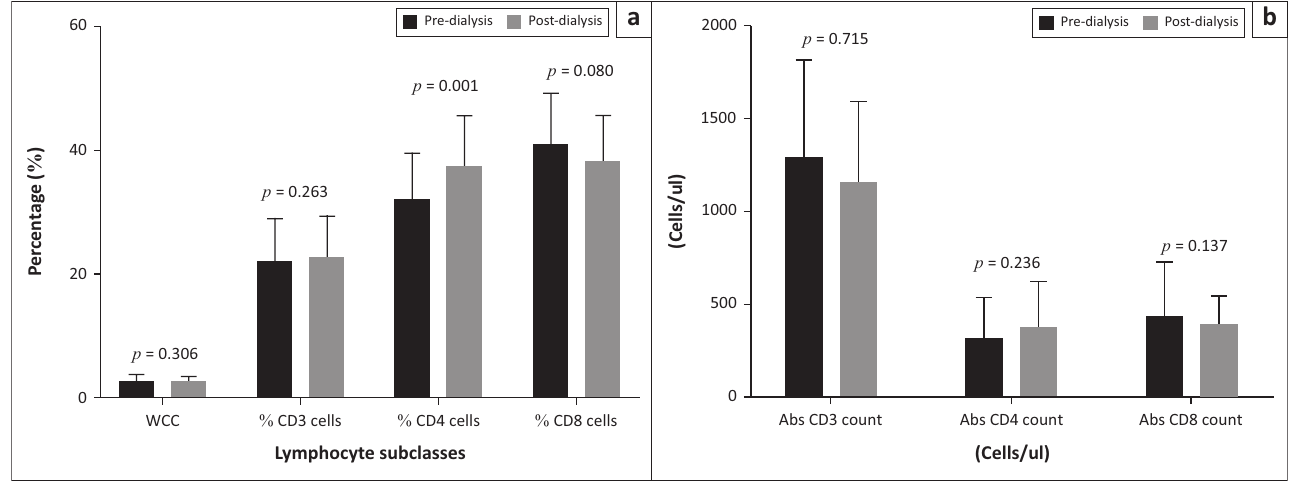
FIGURE 2: Measured parameters of study controls pre- and